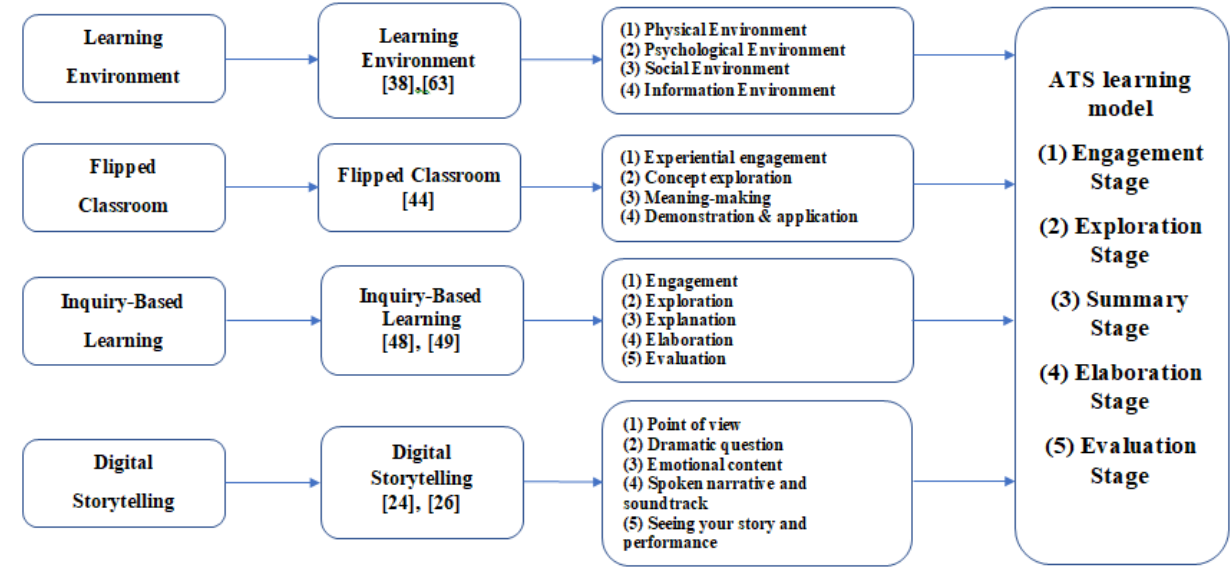
Figure 1. Proposed ATS learning